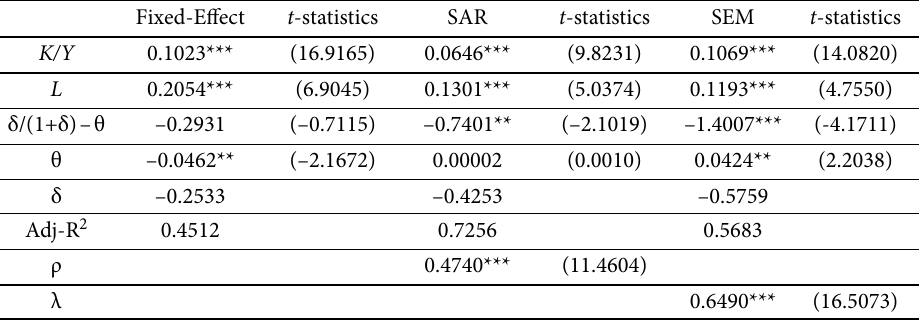
Table 3. Spatial econometric estimations of dual-sector feder model